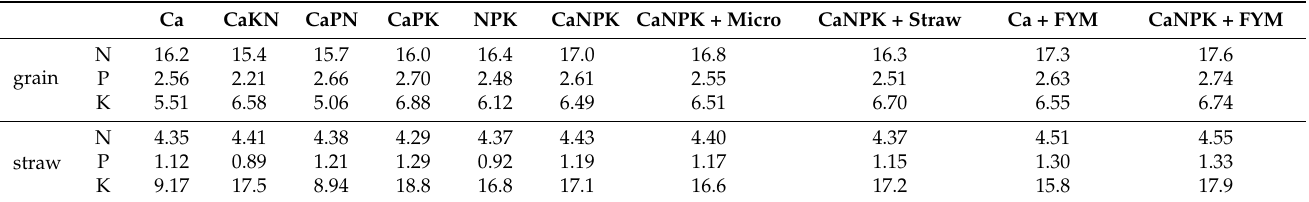
Table 4. Content of N, P, K in grain and straw in g kg − 1 in experiment 2 (monoculture) in 2017.